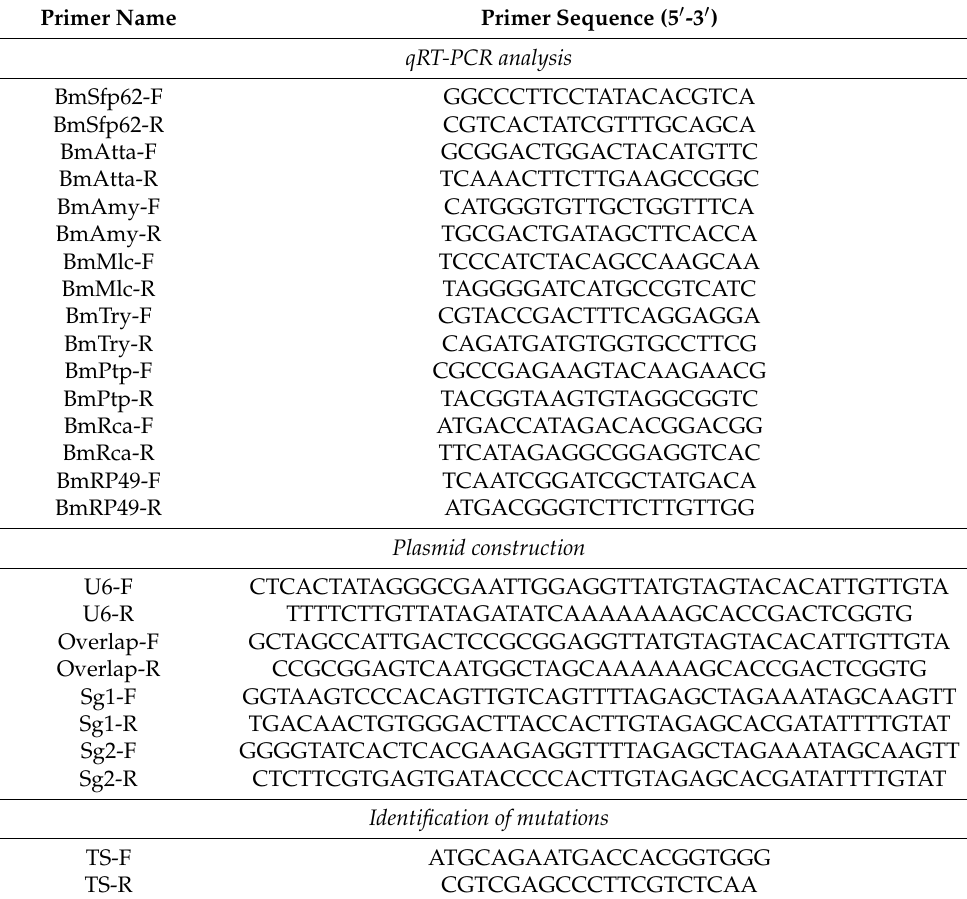
Table 1. Primers used in